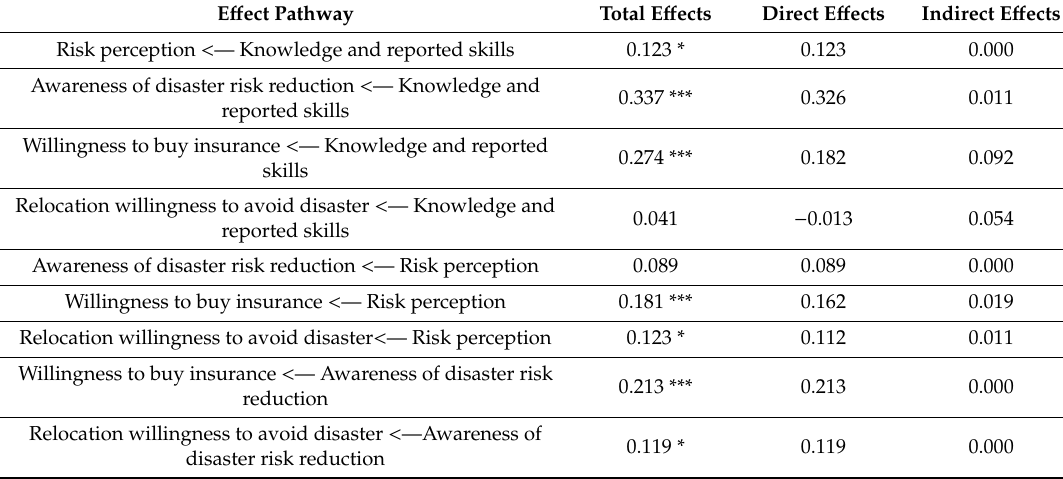
Table 8. The results of total e ff ects, direct e ff ects, and indirect e ff ects. E ff ect